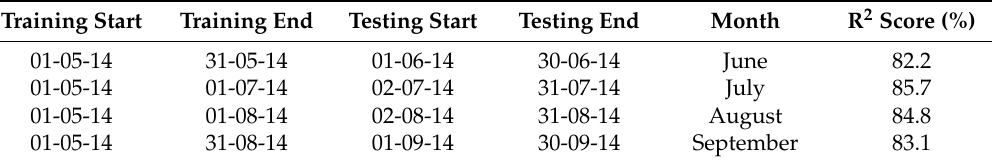
Table 6. Day-ahead online training using Random Forest Decision Tree.